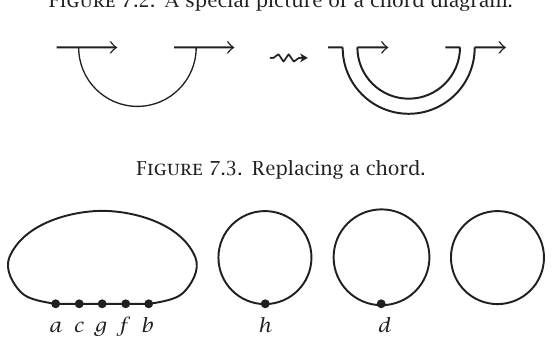
Figure 7.4 . A standard embedding of labeled circles.